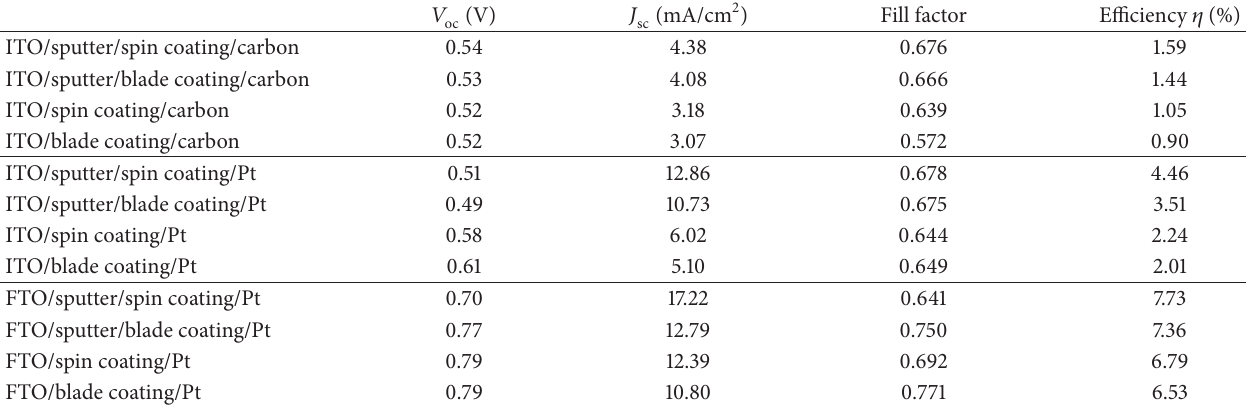
compact layer, using carbon and Pt counter 2